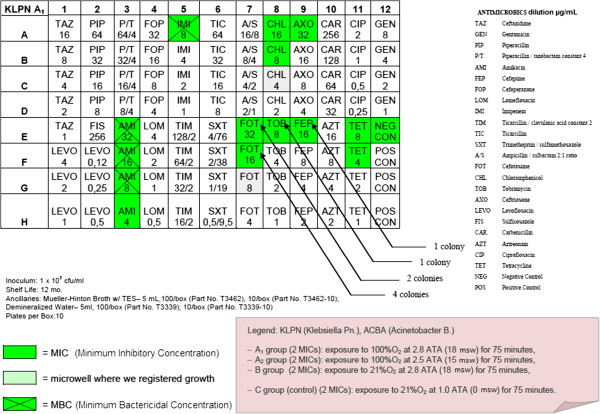
Klebsiella pneumoniae (KLPN) exposed to 100% O2at 2.8 ATA.